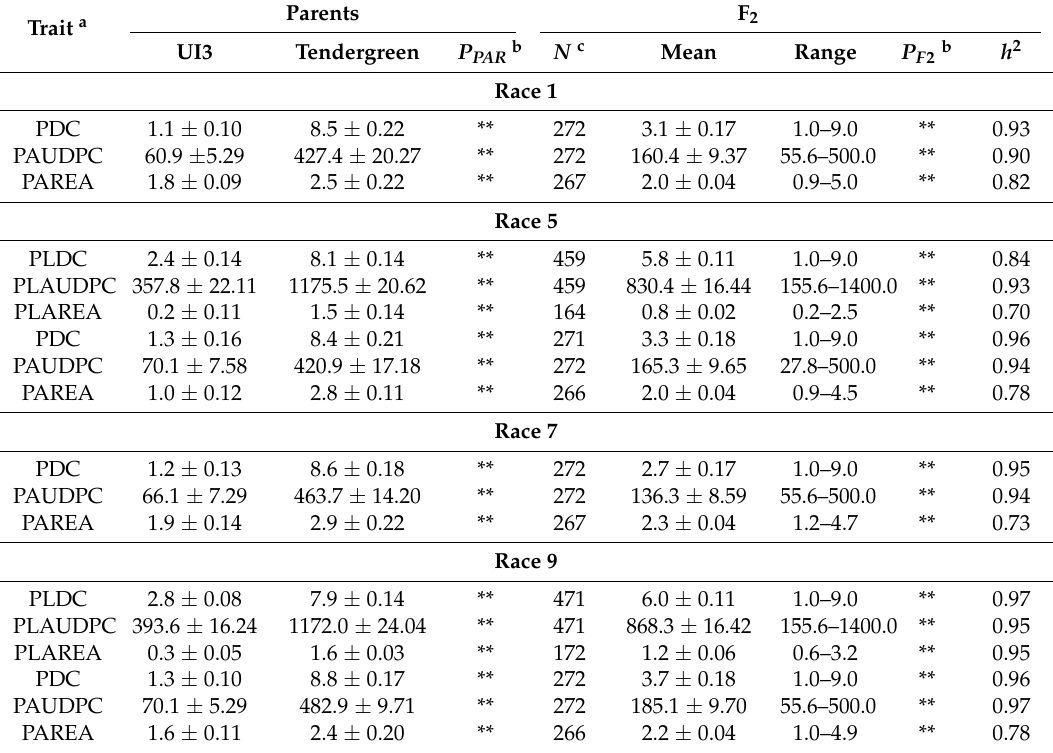
Table 1. Mean, standard error, range of variation, variance analysis results and narrow-sense heritabilities ( h 2 ) for DC, AUDPC and AREA for primary leaf and pod against halo blight races 1, 5, 7 and 9 of the two common bean parents, UI3 and Tendergreen, and the F 2 UI3T population.